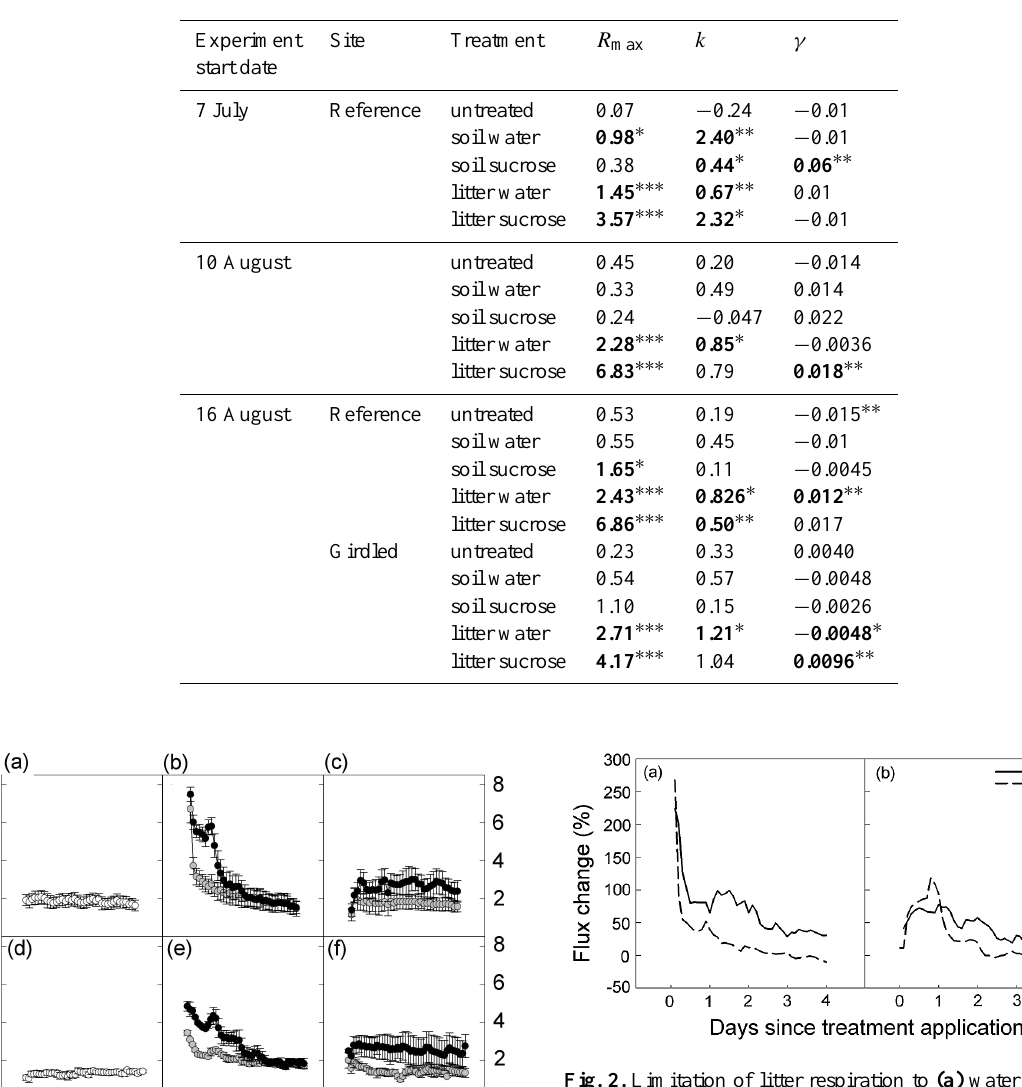
Fig. 2. Limitation of litter respiration to (a) water and (b) sucrose over time for reference site experiments 1 (7 July) and 2 (10 August